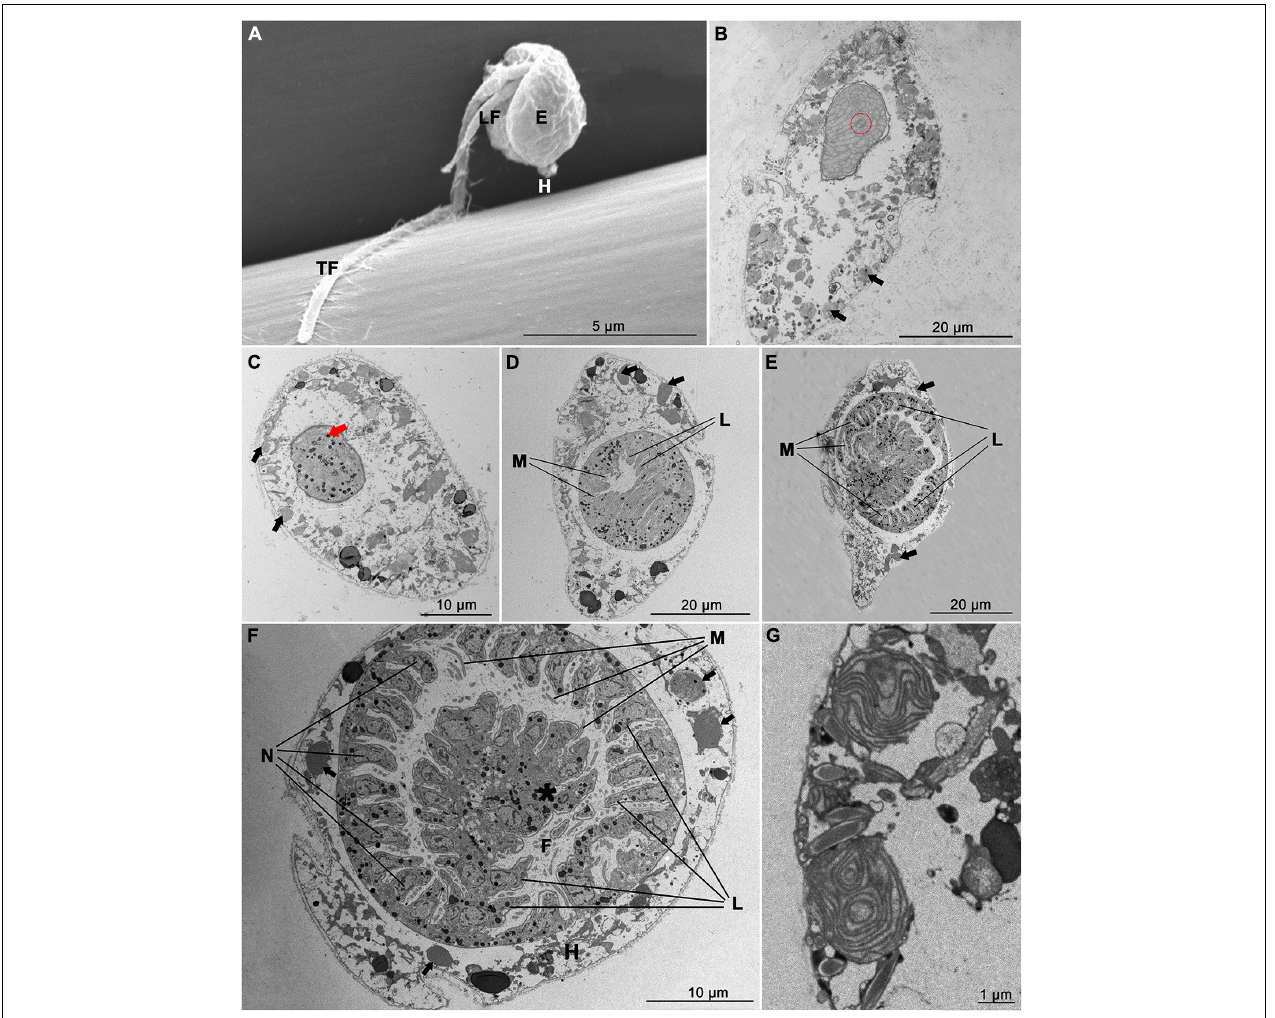
FIGURE 3 | Electron micrographs of free-swimming dinospores and Amoebophrya sp. within Akashiwo sanguinea . (A) Scanning electron microscope image of Amoebophrya sp. dinospore showing the episome (E), hyposome (H), longitudinal flagellum (LF), transverse flagellum (TF), and flagellar hairs (black arrow). (B–G) Transmission electron microscope images of A. sanguinea infected with Amoebophrya sp. Black arrows indicated the chloroplast of A. sanguinea . (B) Uninfected A. sanguinea showing nucleus, nucleolus (red circle) and nucleus membrane. (C) 12 h infection with multiple parasite (red arrow) in host nucleus. (D) 30 h infection showing nascent mastigocoel (M) and multilobed cavity (L). (E) 54 h infection showing “beehive” with fully developed mastigocoel (M) and multilobed cavity (L). (F) Transverse section through 54 h Amoebophrya sp. trophont within the A. sanguinea nucleus. The host cytoplasm (H) was relegated by the parasite to the margin of the cell. The mastigocoel (M) contains numerous flagella (F), and the nucleus (N) line up in a continuous fashion along the folds of the “beehive.” Asterisk indicated the clusters of parasite trichocysts. (G) Detail of chloroplasts in the 54 h infected A. sanguinea